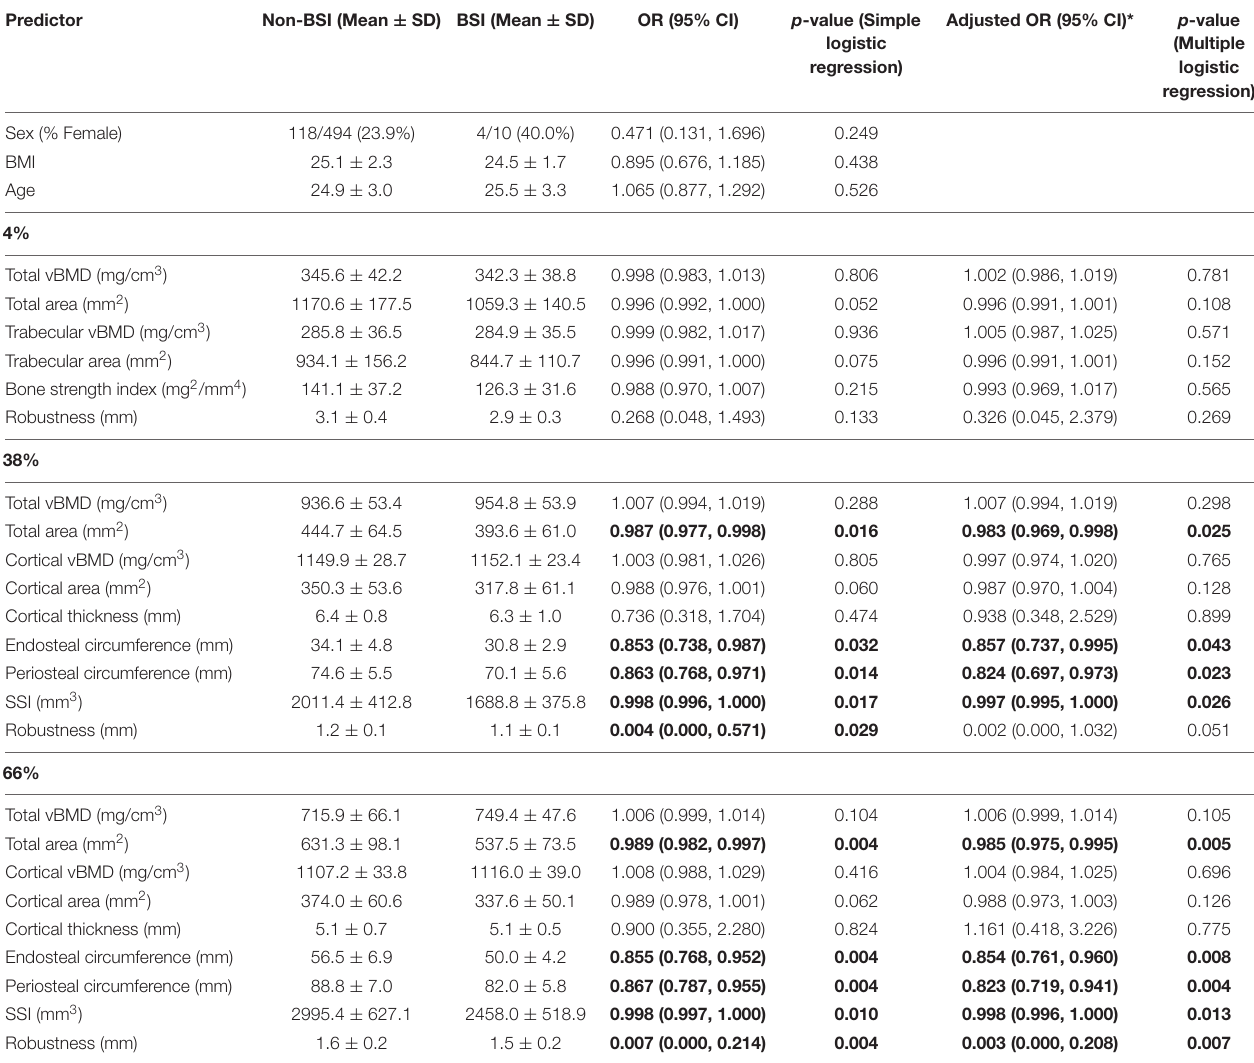
TABLE 3 | Tibial volumetric bone density (vBMD), geometry, and estimated strength in Marine Corps officer candidates who developed a tibial bone stress injury (BSI; n = 10) during training and those that did not (Non-BSI; n = 494).